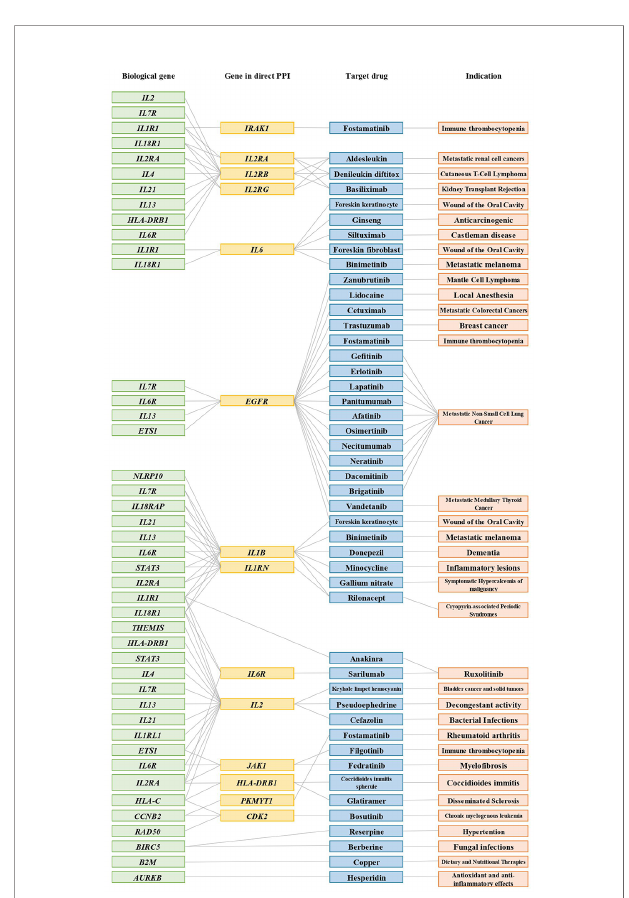
FIGURE 5 | Connections between biological AD risk genes and drugs that were approved for other indications. Representative connections between AD biological genes (green); genes in PPIs (yellow); target drugs (blue); indication (orange). Grey lines indicate connections. Only IL1R1, BIRC5, B2M , and AURKB are directly connected to a biological gene-drug (anakinra, reserpine, berberine, copper, hesperidin); all other biological gene-drug connections are through the PPI